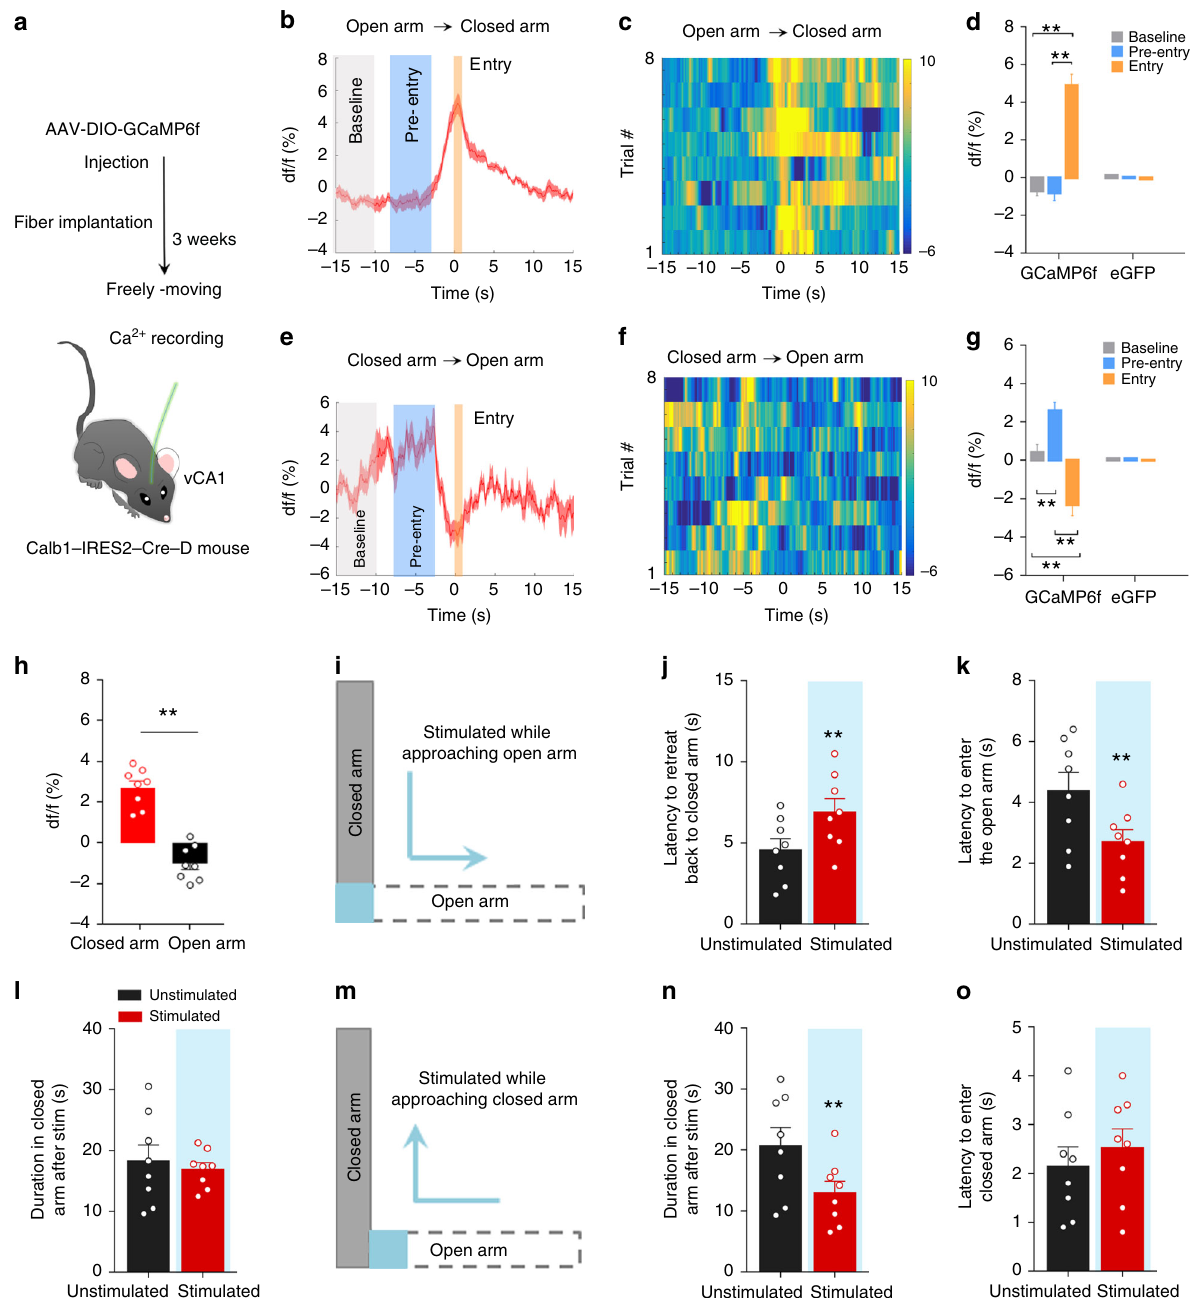
Fig. 4 vCA1 Calb1 + neurons promote approach in con fl ict exploratory tasks. a Schematic of Ca 2 + recording in the EPM. b , e Average Ca 2 + transients from vCA1 Calb1 + neurons during the behavioural transition between closed-arm and the open-arm compartments (transition point at time 0 s) ( n = 7 or eight mice per group). c, f Heat maps of normalised Ca 2 + activity in vCA1 Calb1 + neurons during transition, as shown in b and e . Average df/f for baseline, pre- entry, and entry periods in GCaMP6f mice and control GFP mice during transition from open to closed arms ( d ) or closed to open arms ( g ). Two-way ANOVA, closed to open arm: F (2, 26) = 17.63, P < 0.0001, Tukey ’ s multiple comparisons test, ** P < 0.01; open to closed arm: F (2, 26) = 47.83, P <